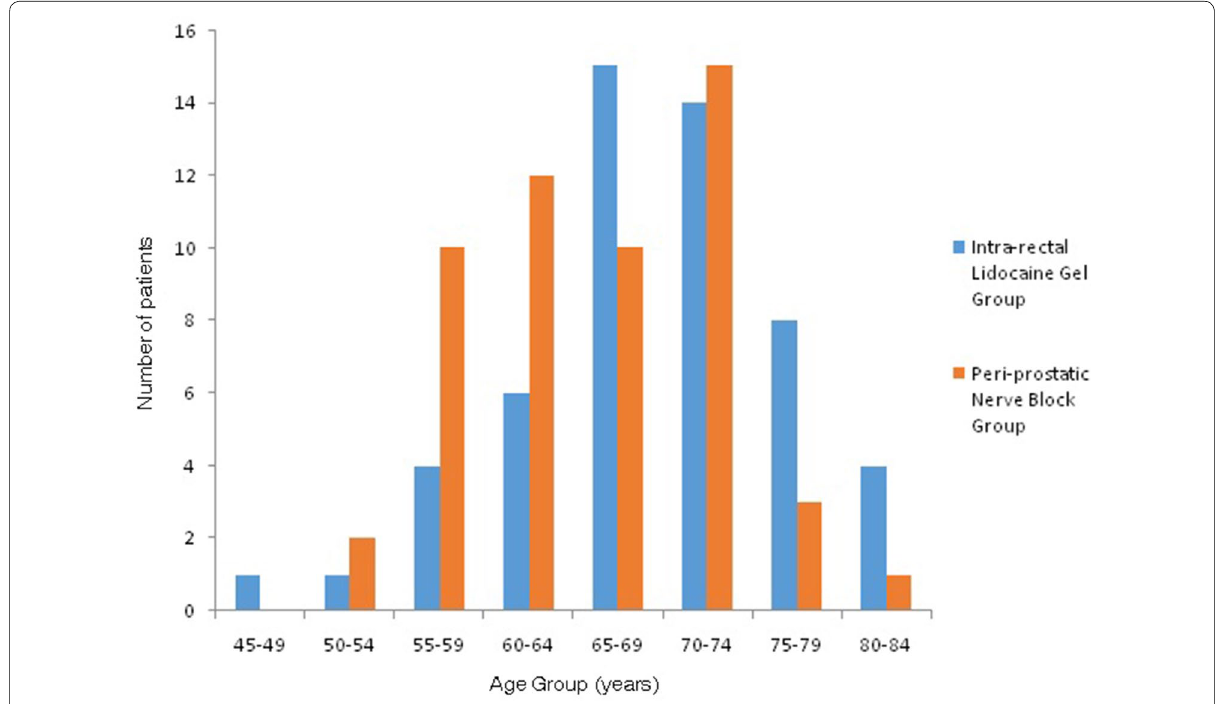
Fig. 1 Age group of patients who had prostate biopsy in the two study